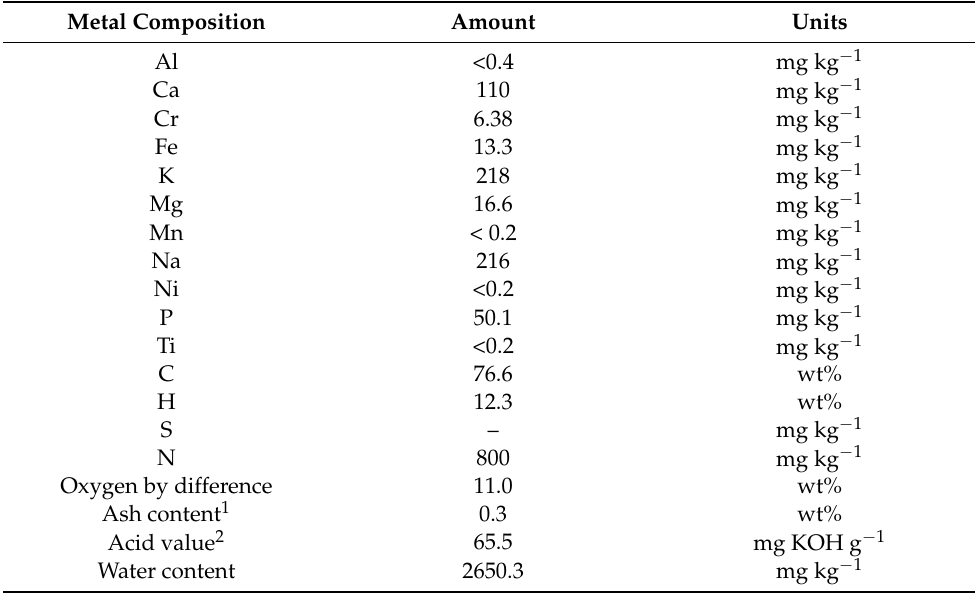
Table 1. Metals and elemental C, H, N, S, O percent (oxygen calculated by difference) and ash composition for the rendering fat